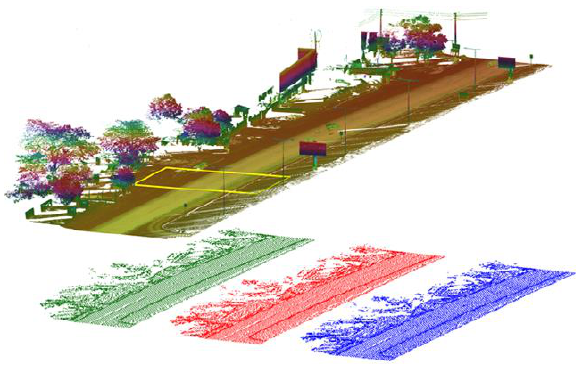
Figure 10. Different cell shape results, squares (green), hexagons (red) and triangles (blue)